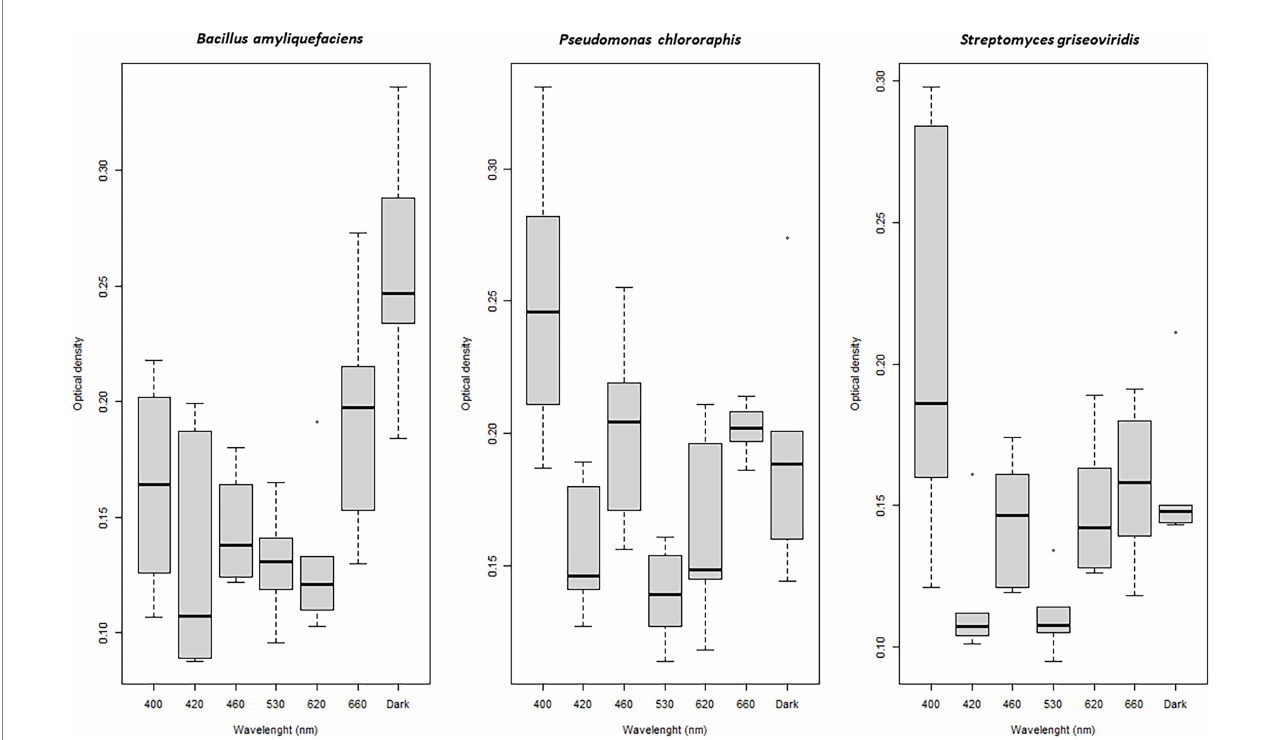
FIGURE 4 Boxplot of biofilm formation by Bacillus amyloliquefaciens , Pseudomonas chlororaphis , and Streptomyces griseoviridis after 96 h of exposure to different wavelenghts (biofilm measured as optical density at 550